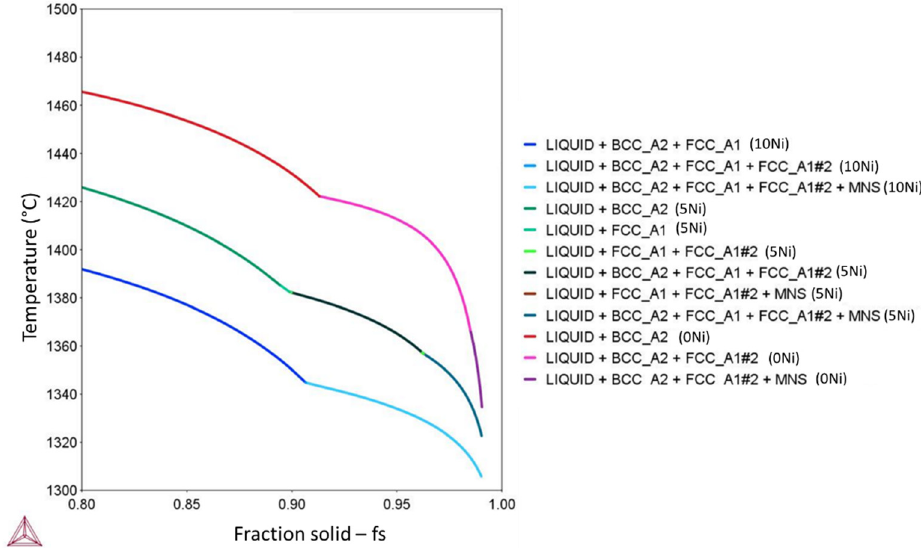
Figure 6. Equilibrium solidification curve according to the Scheil method above 0.8 fraction solid.